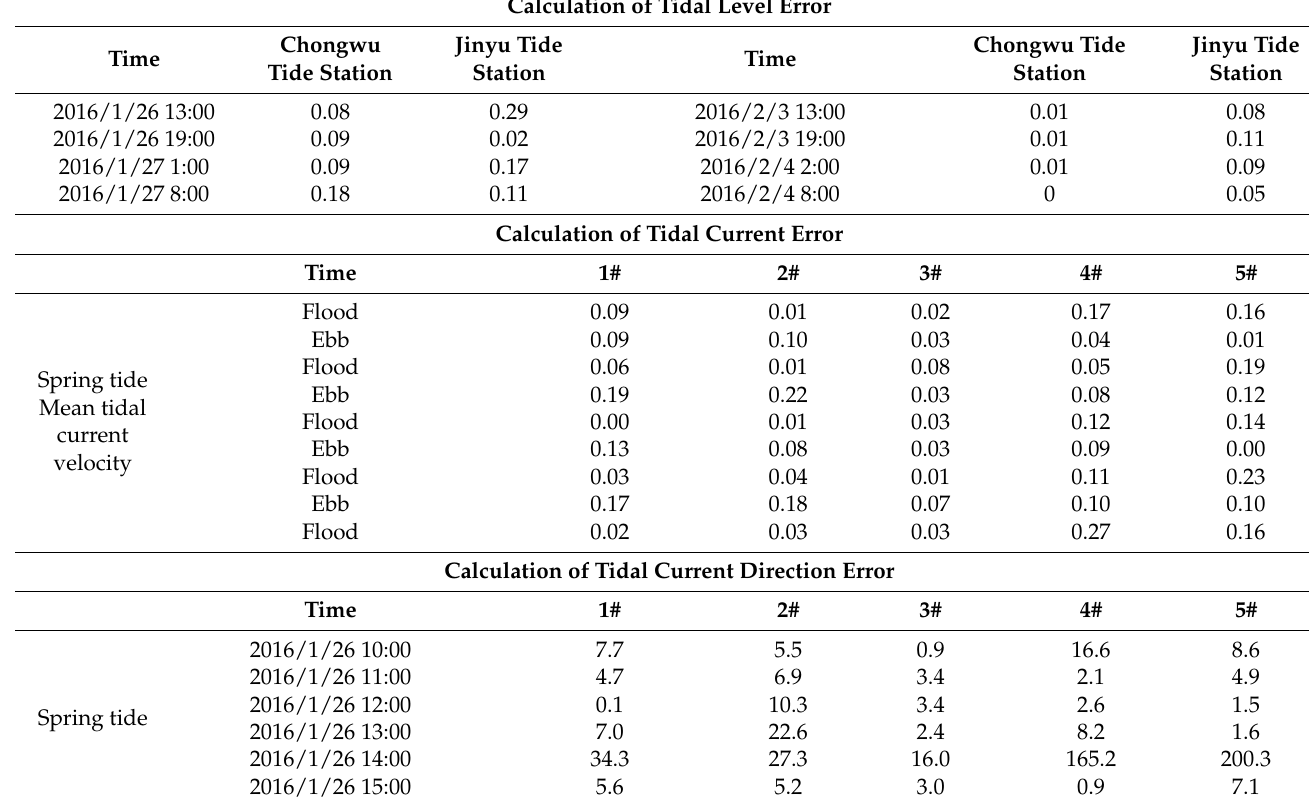
Table 3. Model error